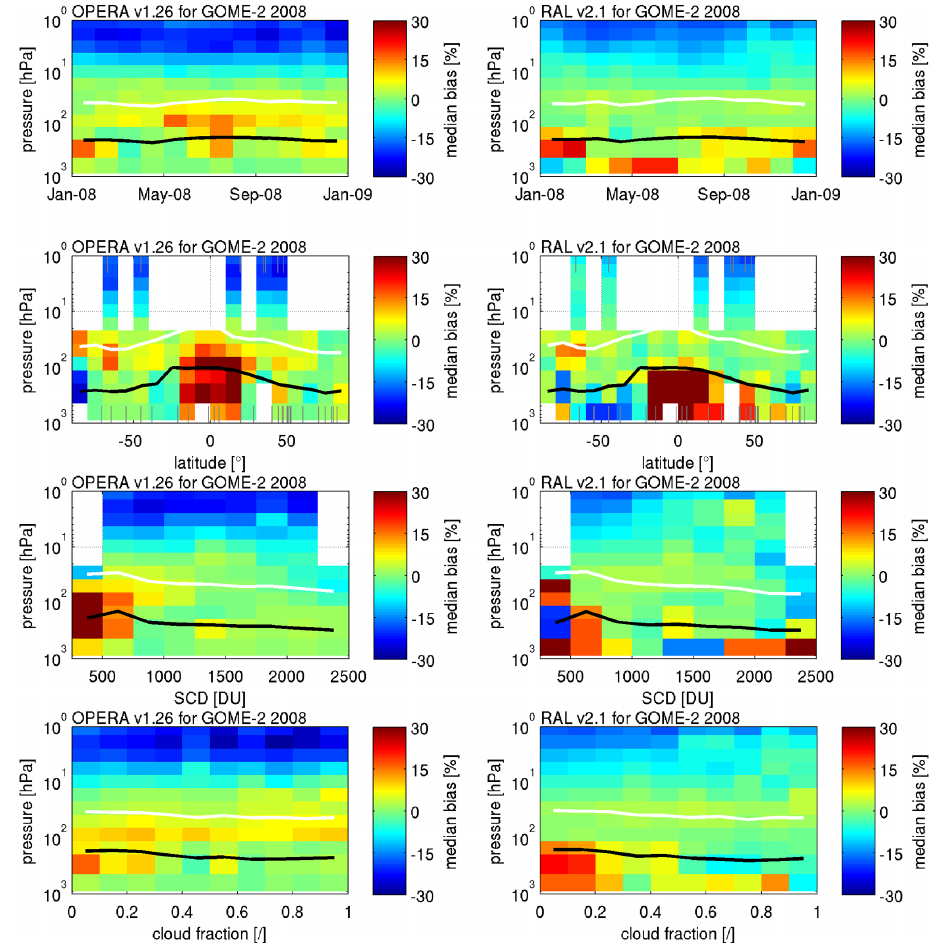
Figure 9. Temporal, meridian, SCD, and cloud fraction dependences of the median relative bias of OPERA v1.26 (left) and RAL v2.1 (right) GOME-2 2008 nadir ozone profile retrievals with respect to ground-based ozonesonde and lidar measurements (averaging-kernel-based smoothing at fine resolution). Black and white lines represent the tropopause and ozone maximum,